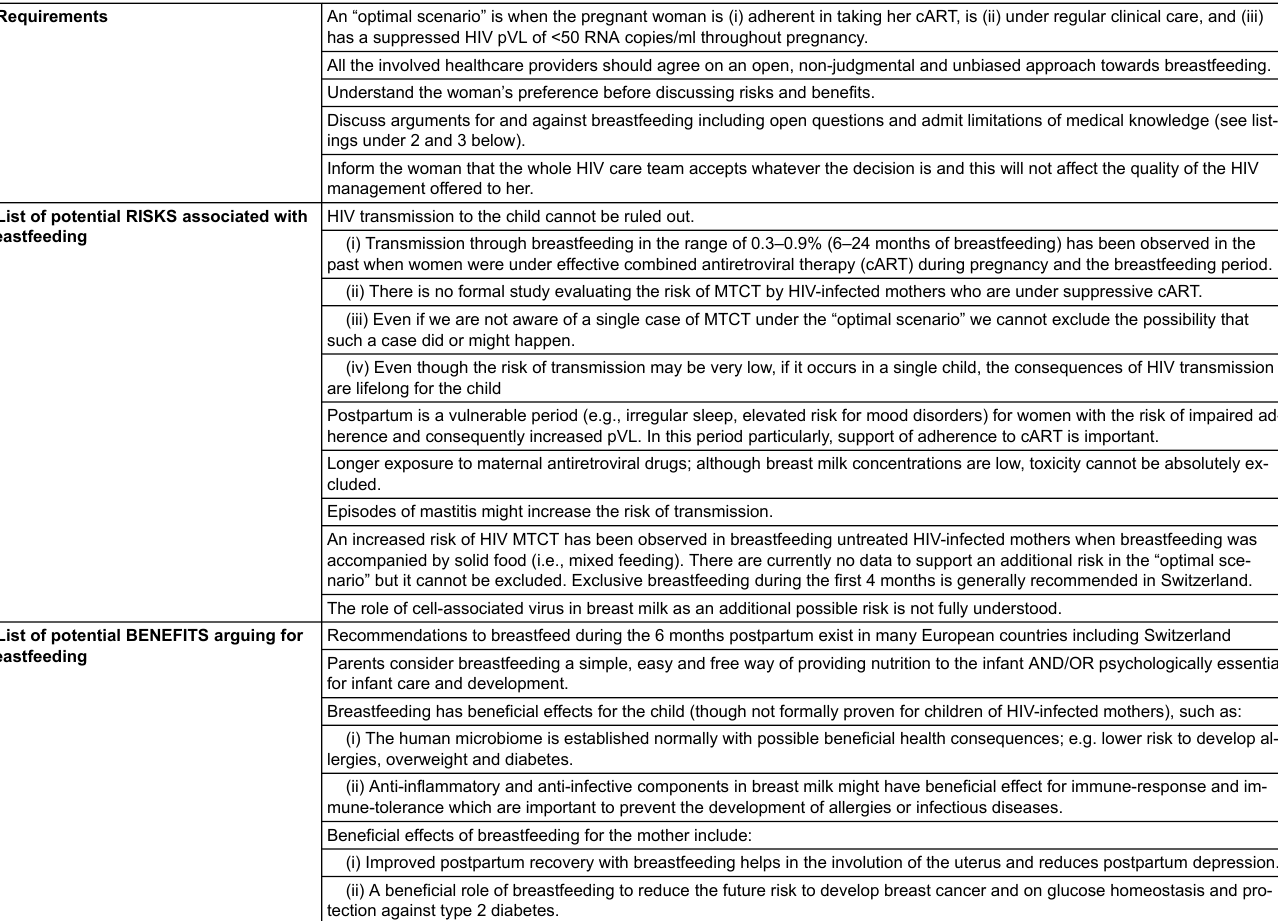
Table 1: Guidance for a shared decision-making process to decide on breastfeeding by HIV-infected mothers fulfilling the “optimal